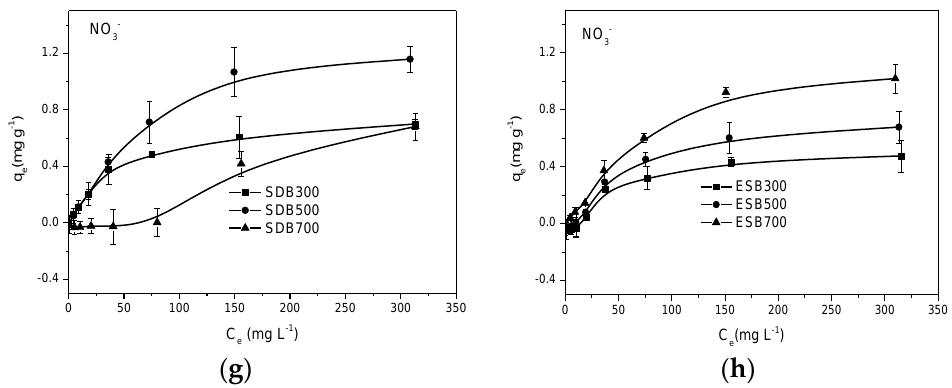
Figure 3. Adsorption isotherms of P and NO 3 − on RSB ( a ), PCB ( b ), SDB ( c ), ESB ( d ), RSB ( e ), PCB ( f ), SDB ( g ), and ESB ( h ), respectively. Data are means ± SD of n = 3.